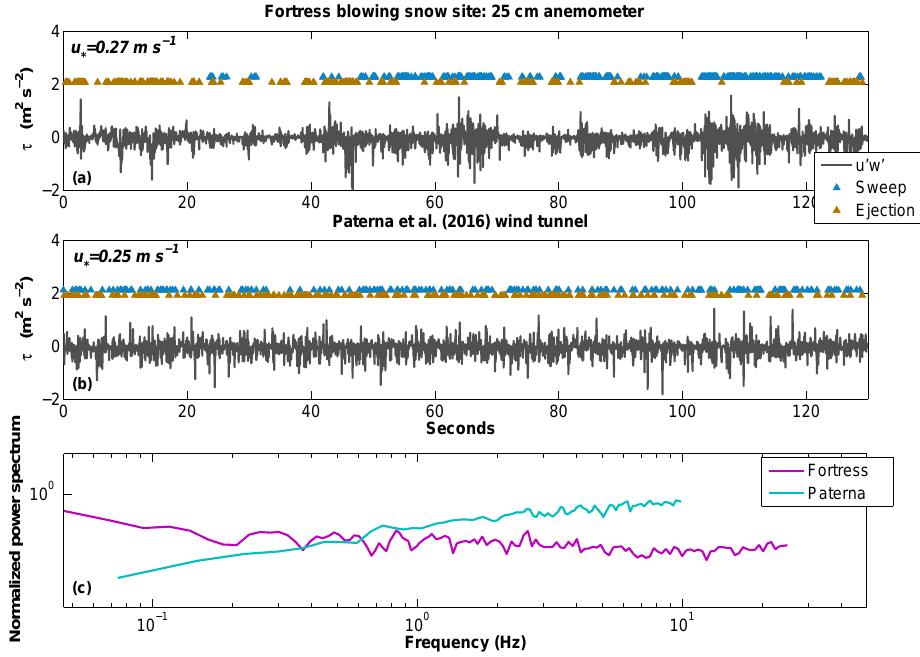
Figure 5. Plots (a) and (b) compare Reynolds shear stress signals from 3 February 2016 and Paterna et al. (2016) wind tunnel blowing snow studies. Triangles indicated sweep and ejection events larger than 1 standard deviation of Reynolds stress. (c) Normalized power spectral density for streamwise velocity for the two time